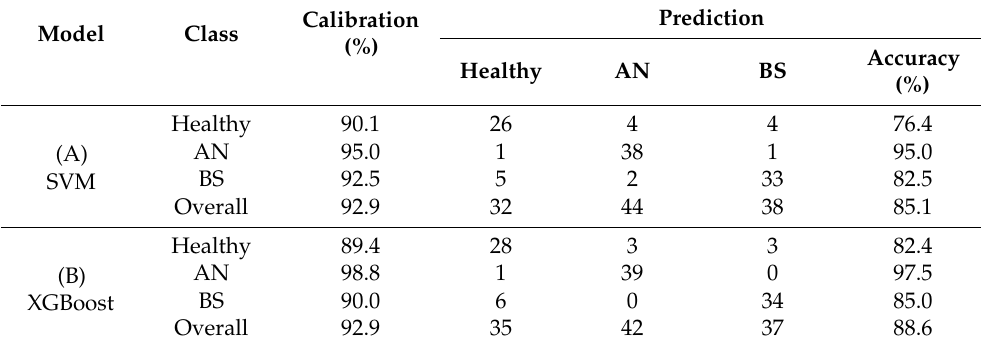
Table 4. Classification results of different diseased (brown spot and anthracnose) cucumbers based on SVM and XGBoost algorithms